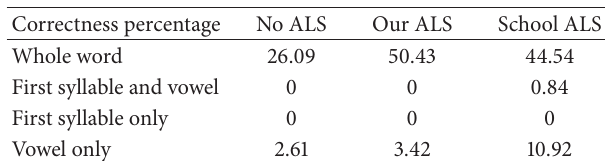
Table 2: Summarised results.